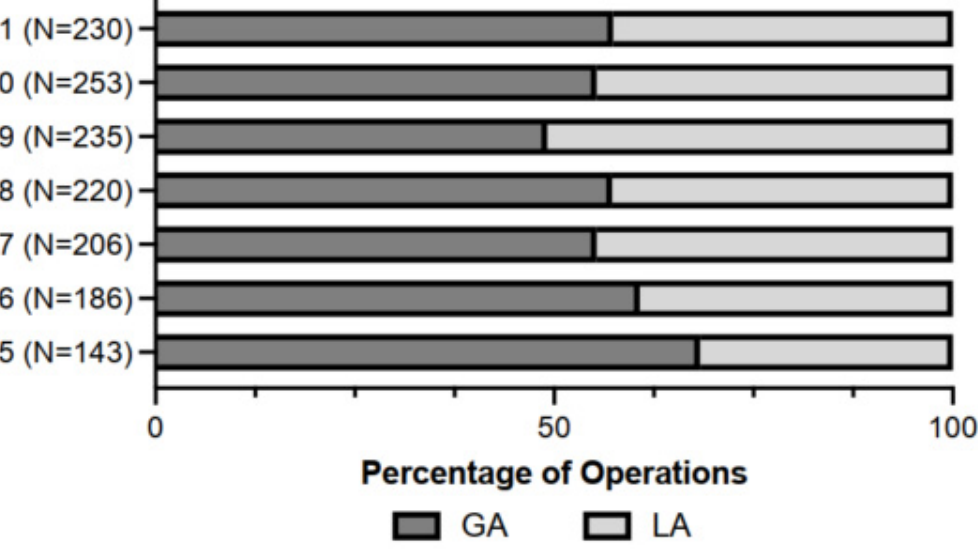
Figure 1. Graph showing patterns of anesthesia used for vitreoretinal surgery during the period between 2015 and 2021.